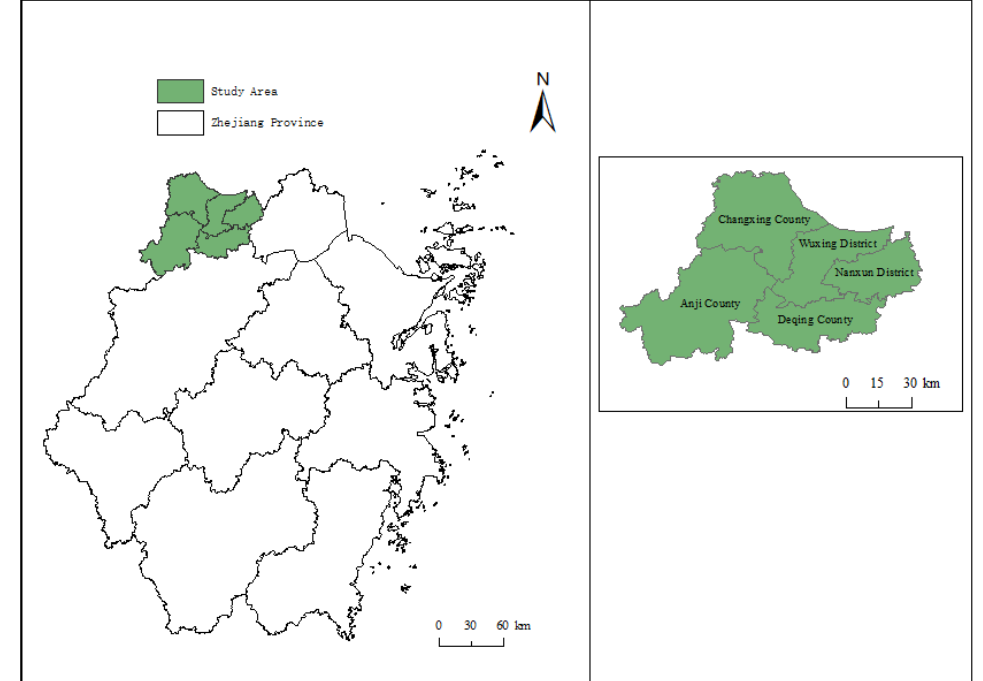
Figure 2. Sketch map of study